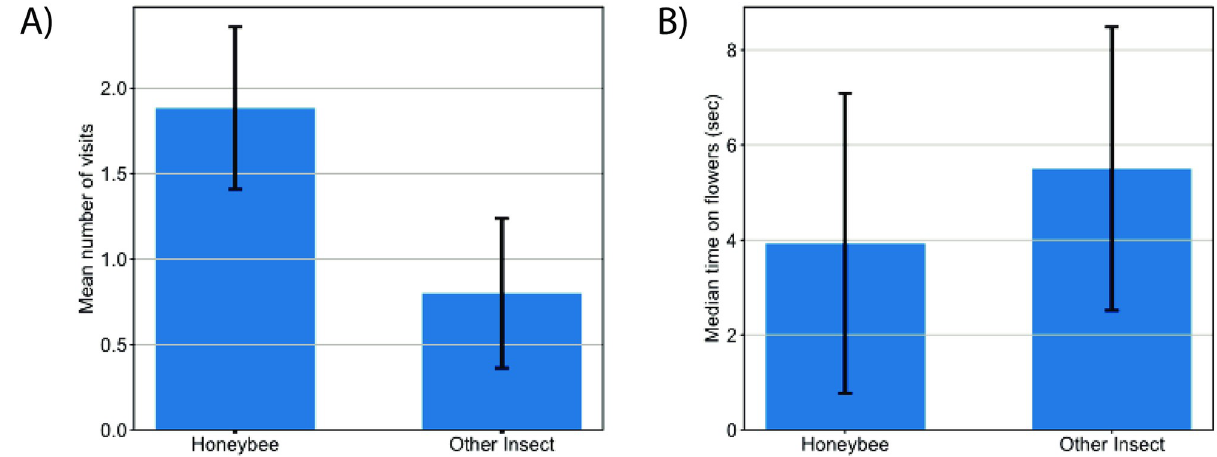
Fig 8. Video-monitored insect flower visitation summary data. (A) Mean number of flowers visited by each insect type (per insect) modelled with a negative binomial model. Bars represent the predicted mean number of visits by each pollinator type (per insect) and error bars at 95% confidence intervals for the predicted mean. (B) Median time spent on flowers for each insect type per insect. Error bars indicate the median absolute deviation.